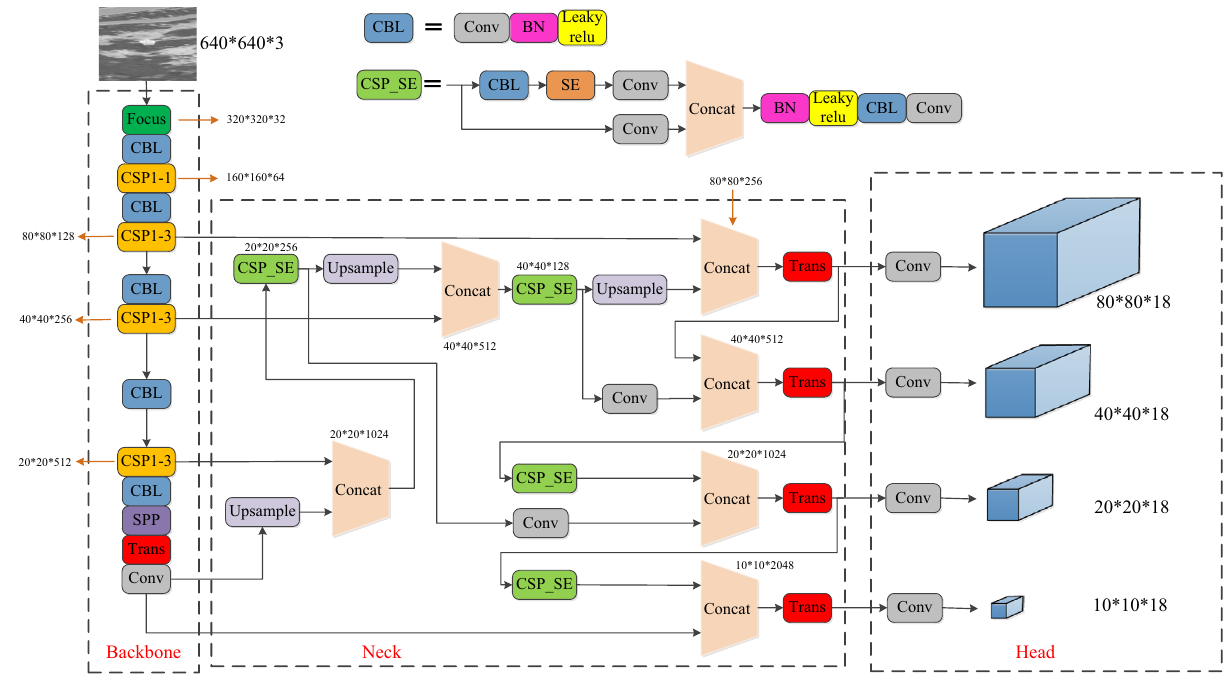
Figure 1. Improved YOLOv5s-THSE network structure